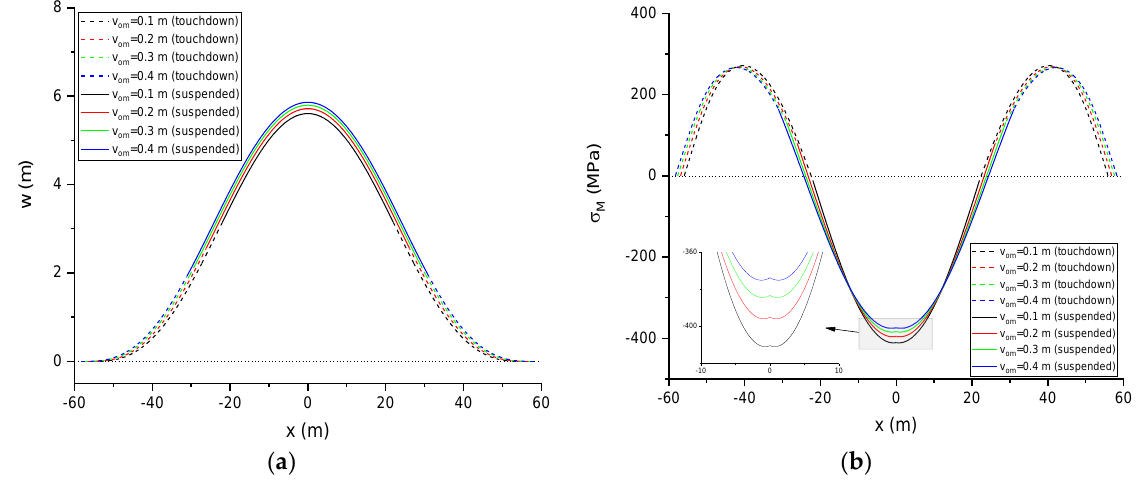
Figure 10. Influence of 𝑣 𝑜𝑚 on configurations. ( a ) Deformed shapes. ( b ) Bending stresses ( 𝜇 𝑏𝑟𝑘 = 2.0 , 𝜇 𝑠 = 0.1 , 𝑇 0 = 40 °C ).